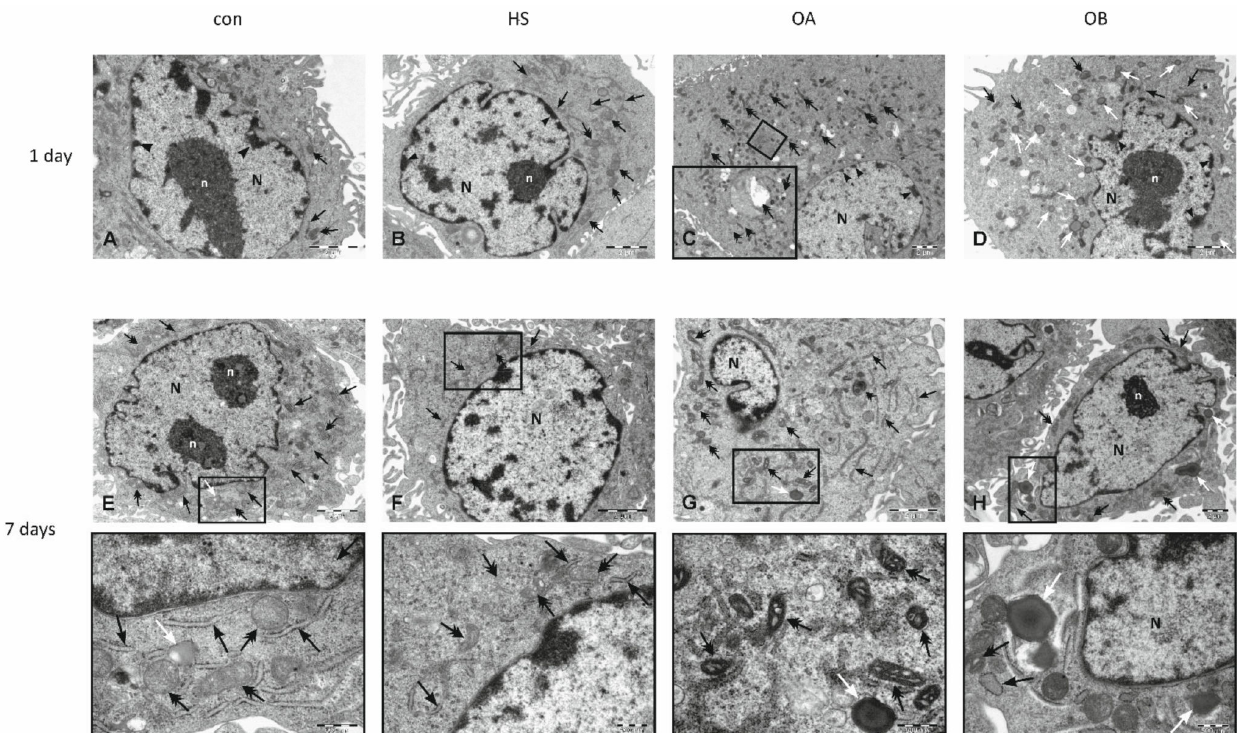
with enlarged intra-cristal spaces (double head arrows). In the cytoplasm, poorly developed RER (black arrows), lipid droplets (white arrows) and individual autophagic vacuole (double arrowhead) can be observed. Note multivesicular bodies present in close proximity to the nucleus and the peripheral region of the cytoplasm (black stars). The inset presents a magnified area of cytoplasm with modified mitochondria and lipid droplets. Changes in mitochondrial architecture (double head arrows) were also observed in cells derived from the HC group ( G ). In the cytoplasm, individual RER cisterns (black arrows) and autophagic vacuoles with an amorphous sub-cellular material were present (double arrowhead). n—nucleolus. The inset presents the cytoplasm’s magnified region located in the nucleus’s close vicinity, where modified mitochondria and vacuoles were observed. Appropriate controls are presented in Figure 6 ( A , B ; one day, E , F ; seven days).